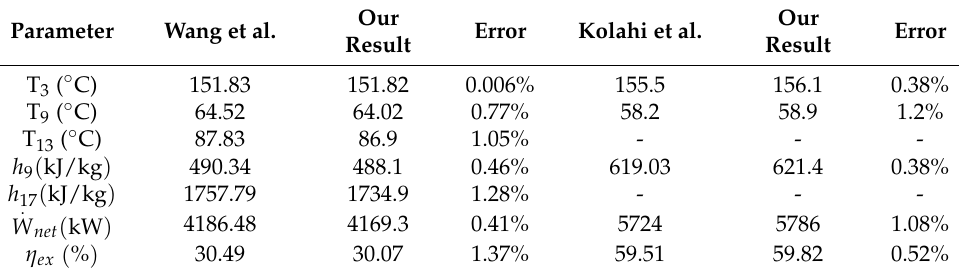
Table 10. Comparison of our results with Wang et al. [31] and Kolahi et al.